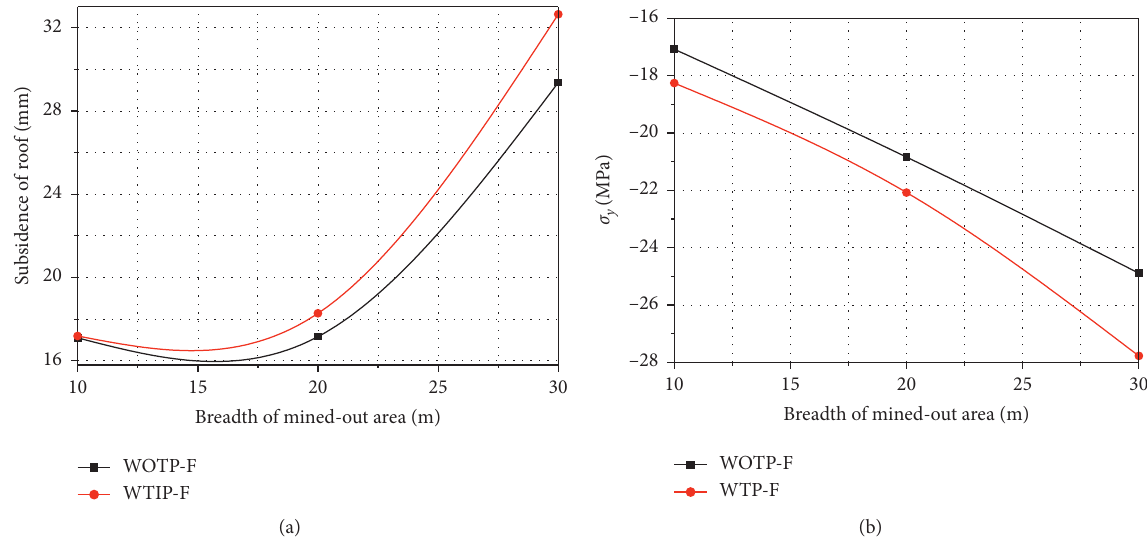
Figure 29: Analysis of calculation of forward direction fult with periodical fracture. (a) Subsidence of the roof. (b) Vertical